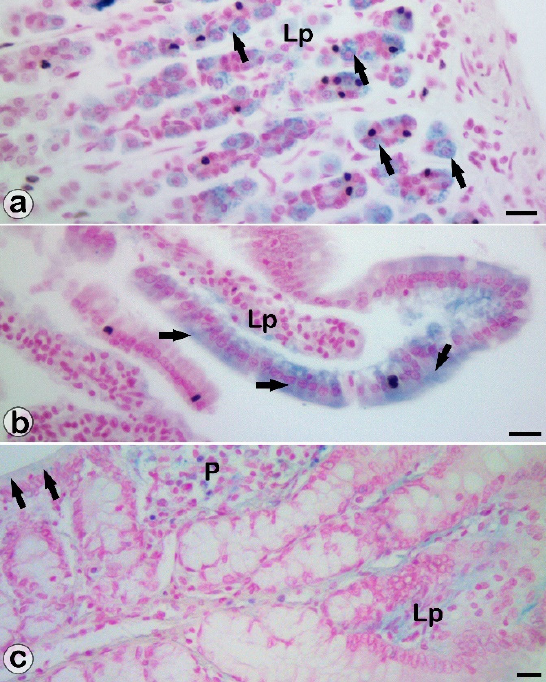
Figure 1. SaIONP deposits (blue colored) in the gastrointestinal-tract walls. Microscopy highlighted SaIONPs in lamina propria (Lp) and epithelium (black arrows) of the basal regions of the gastric glands ( a ), intestinal villi ( b ), Peyer’s patches (P), and glands of the proximal colon ( c ). Viscera harvested 24 h after IG administration of SaIONPs. Perls Prussian blue stainings. Bar = 10 µm.